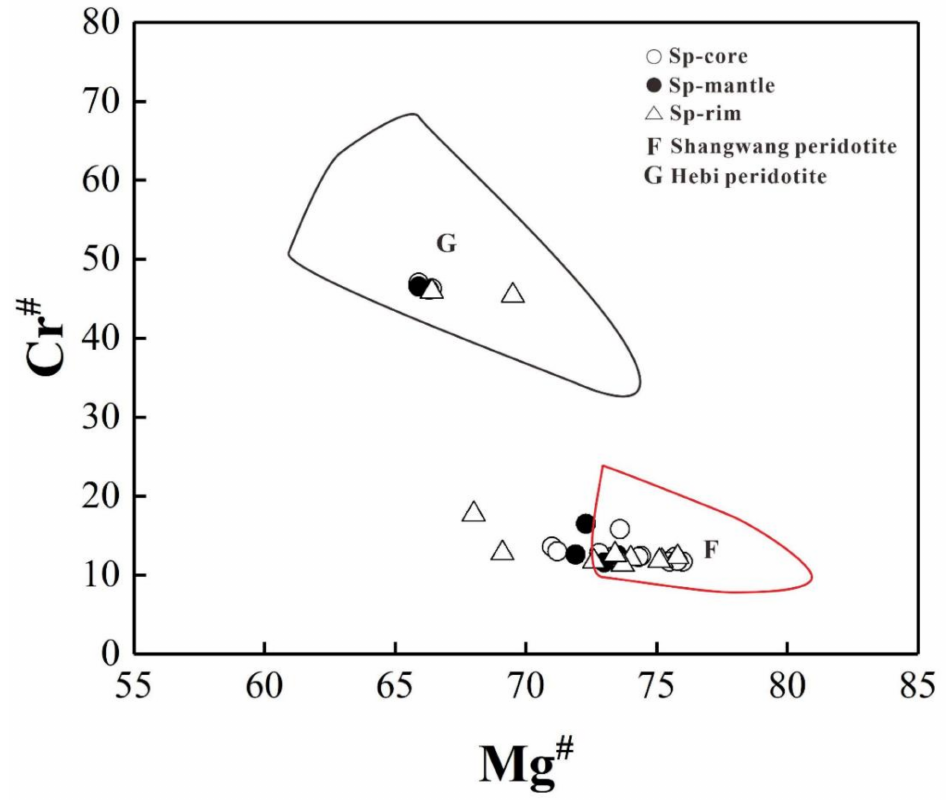
Figure 12. Plots of Mg # -Cr # for the Spinel (Sp). Note: The data of Shanwang and Hebi peridotite are the same as Figure